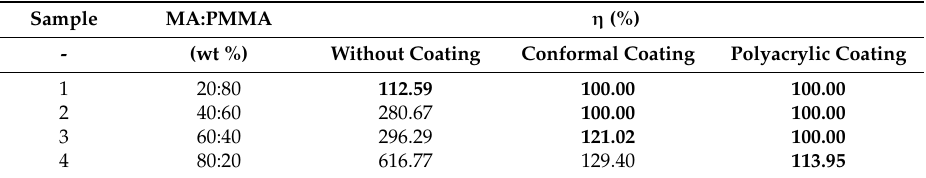
Table 1. Leakage percentages for composite PCMs with and without coatings.